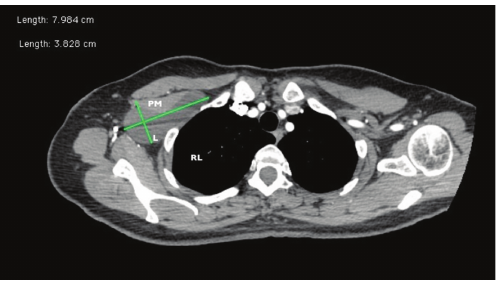
Figure 1: Chest CT with intravascular contrast, axial view. PM: pectoral muscle; L: lymphocele; RL: right lung.